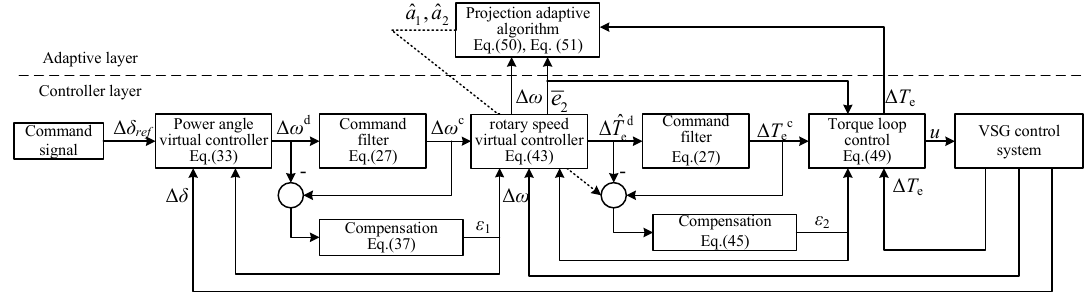
Figure 6. Block diagram of ACB controller for VSG system.